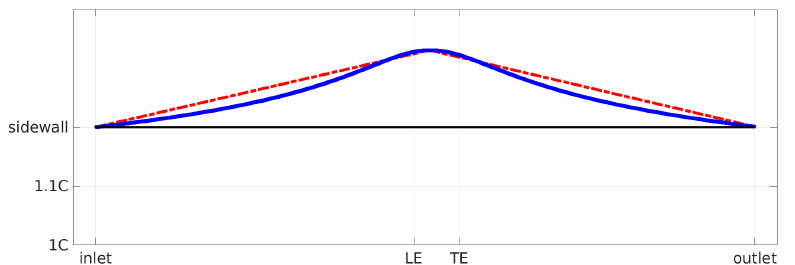
Figure 7. Flow streamlines in the unconfined domain at the equivalent location of wind tunnel top wall; blue: the original curves, red: fitted piece-wise linear curves. Root mean square error of each linear fitting 0.58% C . Physical aspect ratio of the plot is not preserved. LE and TE denote wing leading edge and trailing edge, respectively, which represent the position of the wing inside the tunnel.